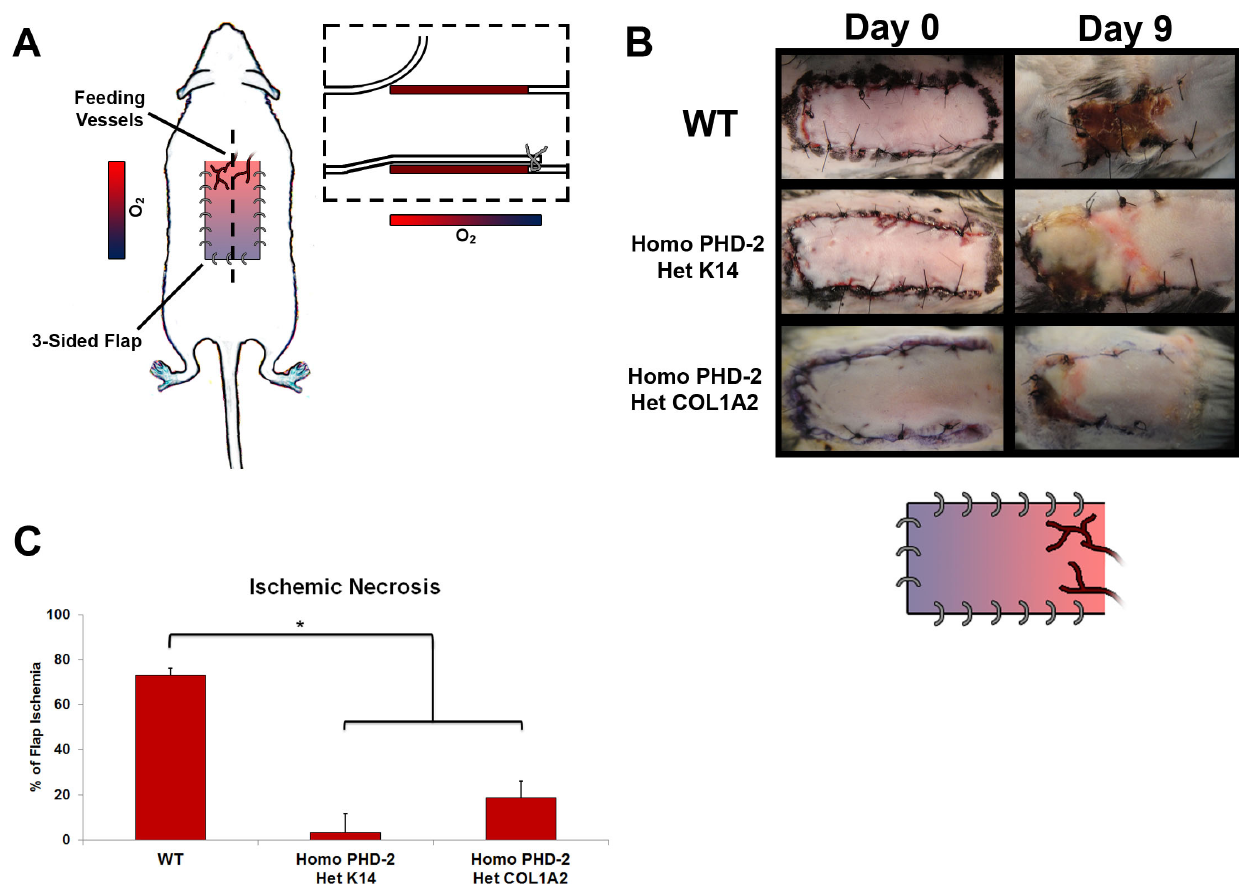
Figure 3. Invivo data from ischemic pedicle flap model. A ) Schematic of ischemic pedicle flap model. B ) Representative figures taken at day 0 and 9 of ischemic flaps for wild type, heterozygous K14-Cre/homozygous floxed PHD-2, and heterozygous Col1 a 2-Cre-ER/homozygous floxed PHD-2 mice. A schematic of tissue reperfusion gradient is also shown. C ) Graphical representation of total flap ischemia with a significant difference (*p , 0.05) between the wild type and the heterozygous K14-Cre/homozygous floxed PHD-2, and heterozygous Col1 a 2-Cre-ER/homozygous floxed PHD-2 mice.